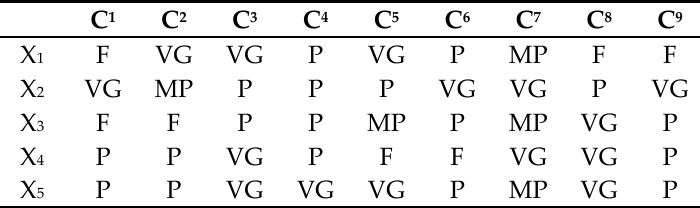
Table 8. Decision matrix in linguistic terms.